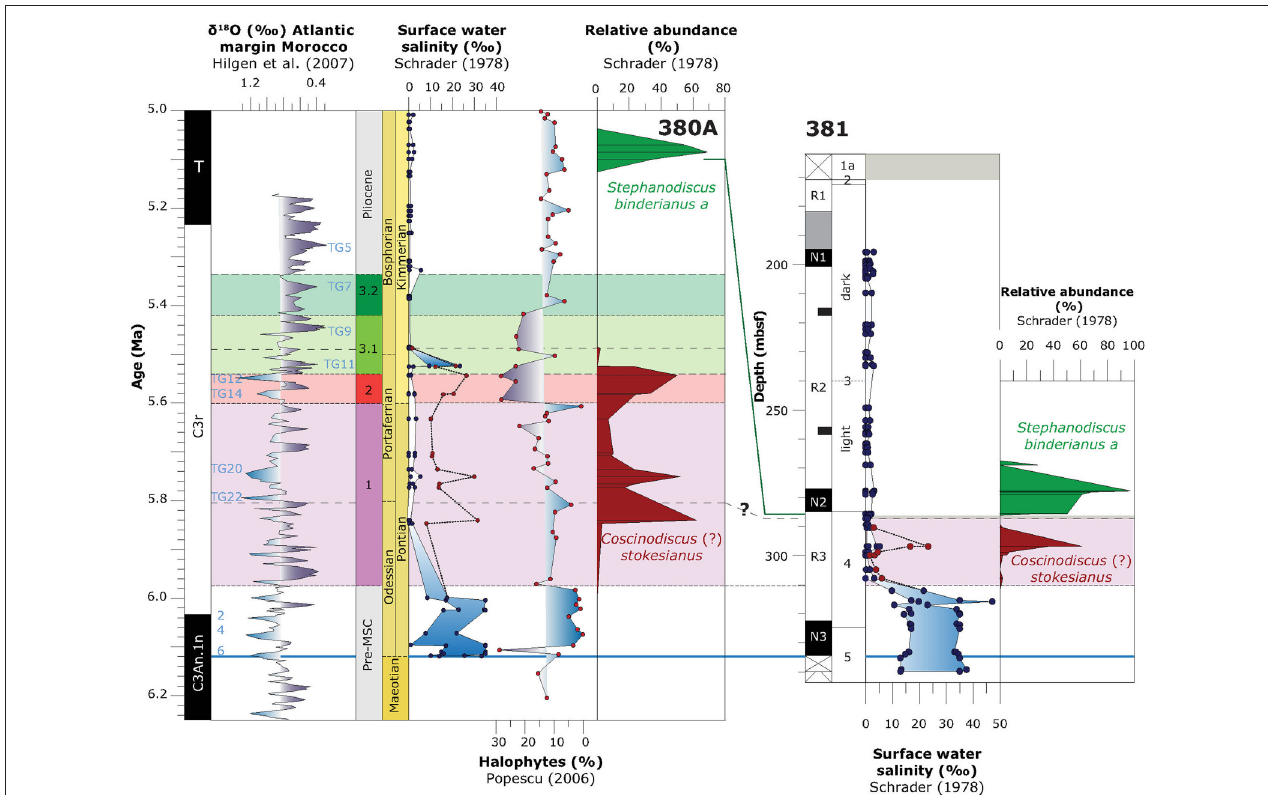
FIGURE 9 | Correlation between Hole 380/380A and Hole 381 for the MSC-related time interval [partly adapted from Van Baak et al. (2015b)]. From left to right for site 380/380A: Age scale; Geomagnetic Polarity ( Hilgen et al., 2012); bentic δ 18 O record of the Atlantic side of Morocco (Hilgen et al., 2007) with (inter) glacial stages indicated; stages of the MSC (Roveri et al., 2014); Paratethyan regional stages (Krijgsman et al., 2010); diatom-based sea-surface salinity at Hole 380/380A ( Schrader, 1978), red symbols indicate calculated alternative maximum salinity based on C. (?) Stokesianus ; Halophyte pollen record (Popescu, 2006), representative for the proximity of the coastline at site 380/380A; relative abundance of diatom species Stephanodiscus binderianus a and Coscinodiscus (?) stokesianus ( Schrader, 1978). From left to right for Hole 381: depth-scale; polarity zones; lithostratigraphic units; diatom-based sea-surface salinity (Schrader, 1978), with in red the alternative maximum salinity based on C. (?) stokesianus ; relative abundance of diatom species Stephanodiscus binderianus a and Coscinodiscus (?) stokesianus ( Schrader, 1978). Horizontal purple, red, and green bars indicate the separate stages of the MSC, blue line indicates the reconnection between Mediterranean Sea and Paratethys at the base of the Pontian stage ( Krijgsman et al., 2010; Chang et al.,